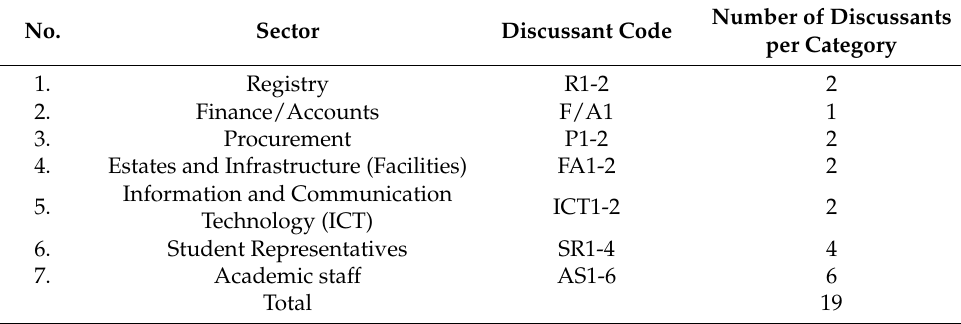
Table 1. Demographics of